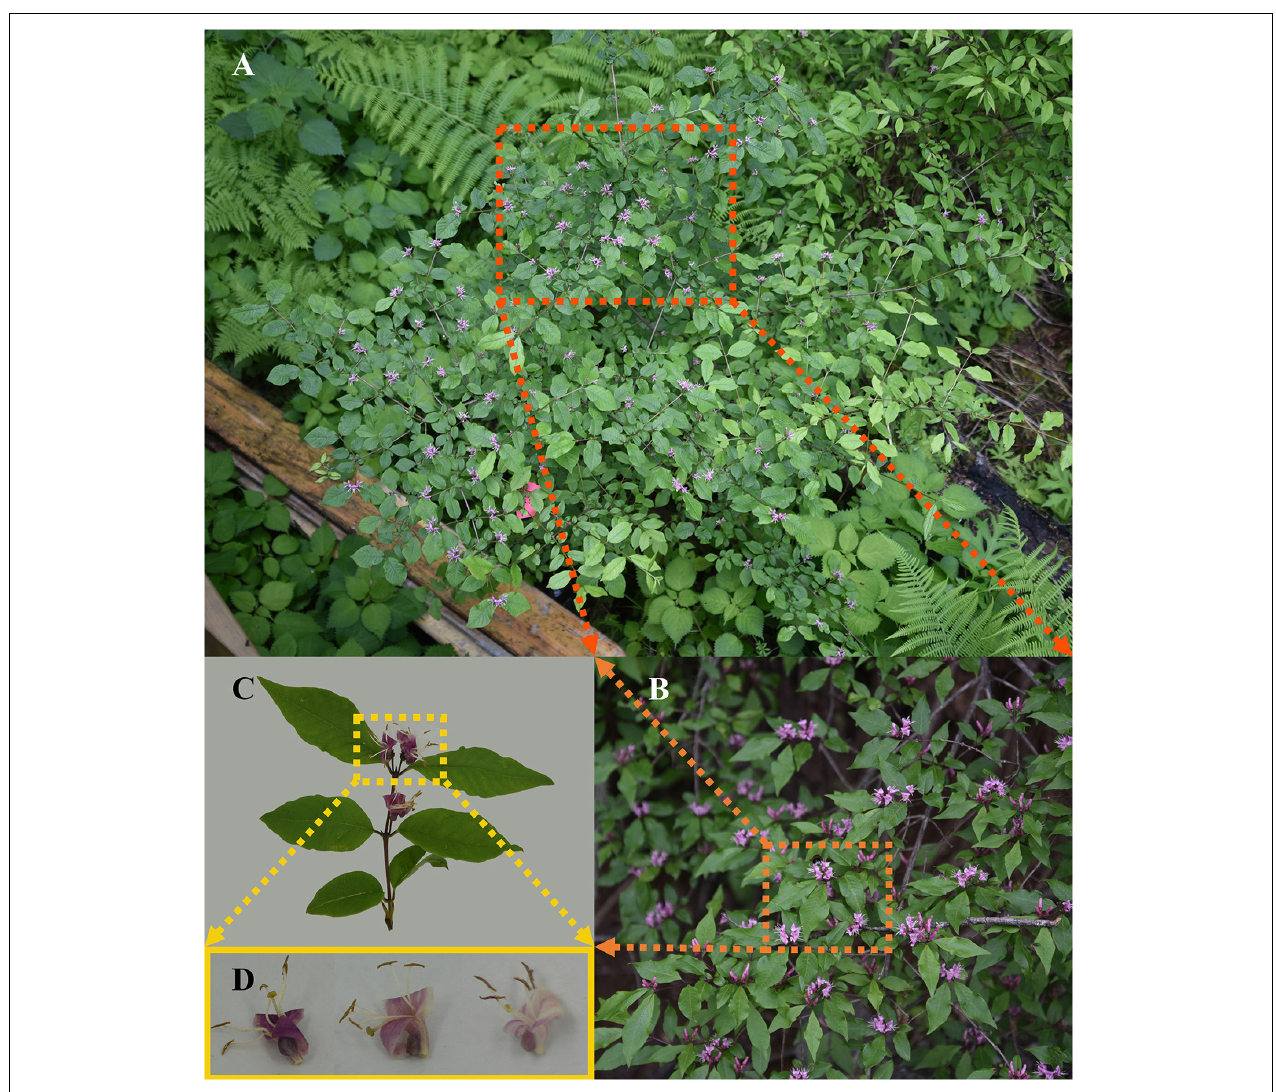
FIGURE 2 | Appearance features of Lonicera nervosa : (A) overview of L. nervosa individual, (B) branches of L. nervosa , (C) details of a twig, and (D) details of flowers with different colors.